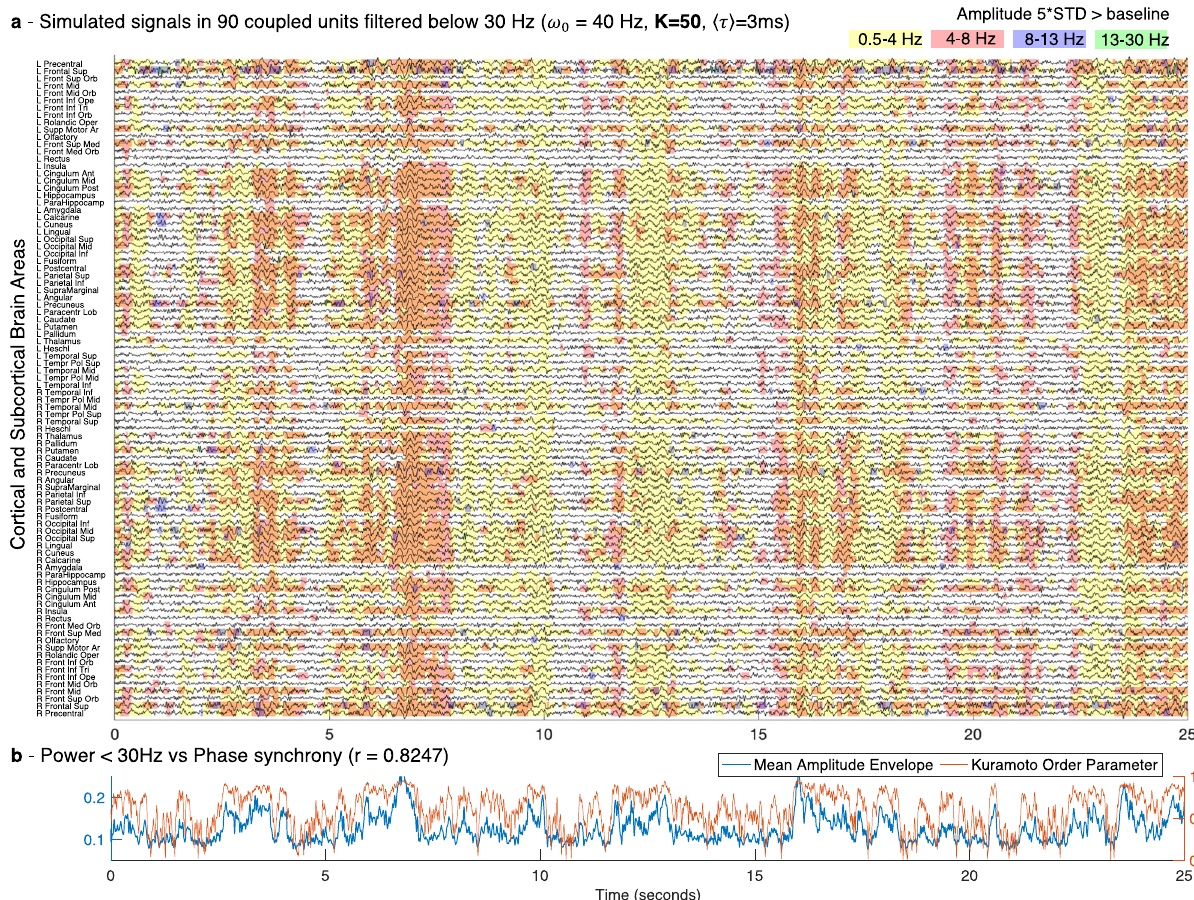
Fig. 5 Global delta waves emerge for strong coupling. a The simulated signals in all 90 units plotted over 25 s, each representing a brain area from a brain parcellation template, fi ltered below 30 Hz to focus on the sub-gamma oscillatory activity typically detected with magnetoencephalography (MEG). Shades highlight the time points of increased power in the delta (yellow), theta (red), alpha (blue) and beta (green) frequency bands. For each frequency band, the threshold was de fi ned as fi ve standard deviations (STD) from the amplitude in the same frequency bands when no delays were considered. These simulations were performed setting the resonant frequency of all units ω 0 = 40 Hz, the average delay between units, 〈 τ 〉 = 3 milliseconds (ms) and the global coupling strength was increased to K = 50 with respect to the simulations shown in Fig. 4. b The mean amplitude envelope (blue) of the fi ltered signals shown in ( a ) correlates with r = 0.8247 with the phase synchronization evaluated by the Kuramoto Order parameter (orange, right y